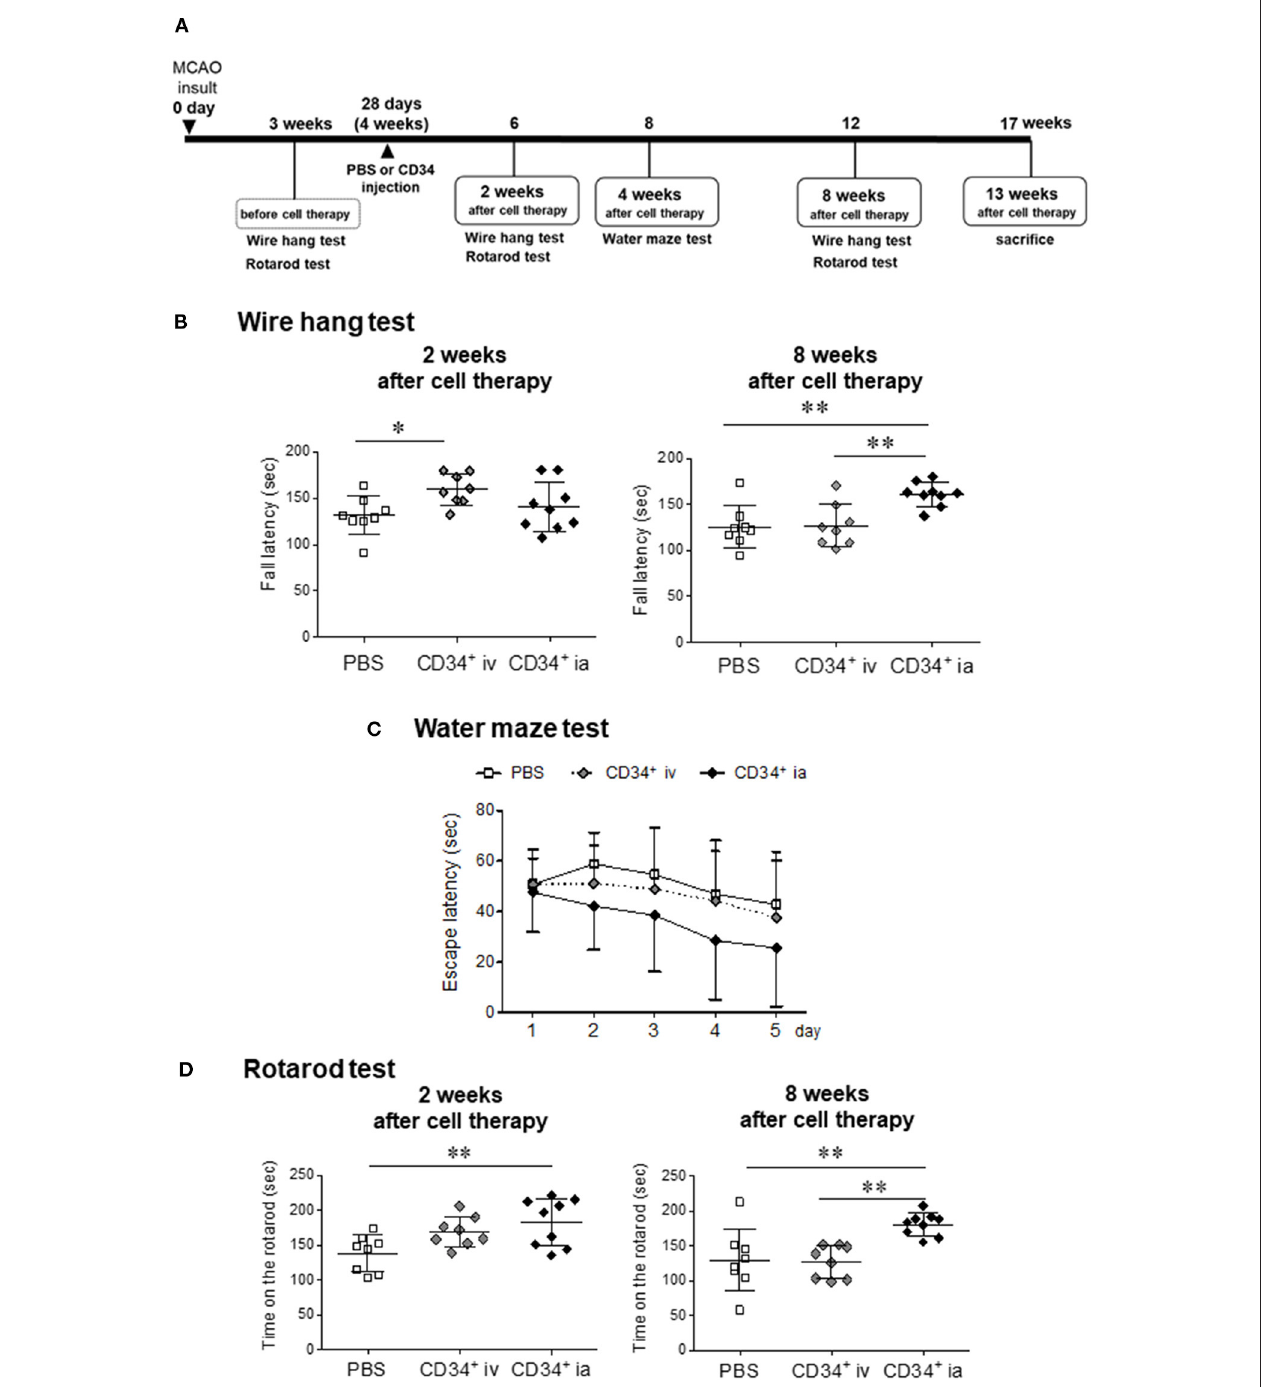
FIGURE 1 | Effect of CD34 transplantation for chronic stroke. (A) Experimental schedule in this study. (B) The neuromuscular function was measured by the wire hang test before treatment, and 2 and 8 weeks after cell therapy. The latency to fall was measured. The hanging time of CD34 + ia treatment groups at 8 weeks after treatment showed a significant longer level compared with the PBS and CD34 + iv treatment group. (C) Water maze test was performed at 4 weeks after the treatment. We measured the time until mice reached onto a platform submerged in a pool for five consecutive days. We presented the average of the 5-day-session data. The escape latency over 5 days of training tended to decrease in CD34 + ia-treated mice, but there was no significant difference between all groups because of large individual differences in each group. (D) Sensorimotor skills were evaluated in the rotarod test before treatment, and 2 and 8 weeks after cell therapy. The rotarod performance means time on the rotarod. Significant difference was observed between PBS and CD34 + ia treatment groups at 2 weeks after the cell treatment. The therapeutic effect persisted 8 weeks after the treatment. MCAO, permanent middle cerebral artery occlusion; CD34 + , autologous peripheral blood CD34 positive cells, iv; intravenous administration group; ia, intra-arterial administration group. * p < 0.05, ** p < 0.01.